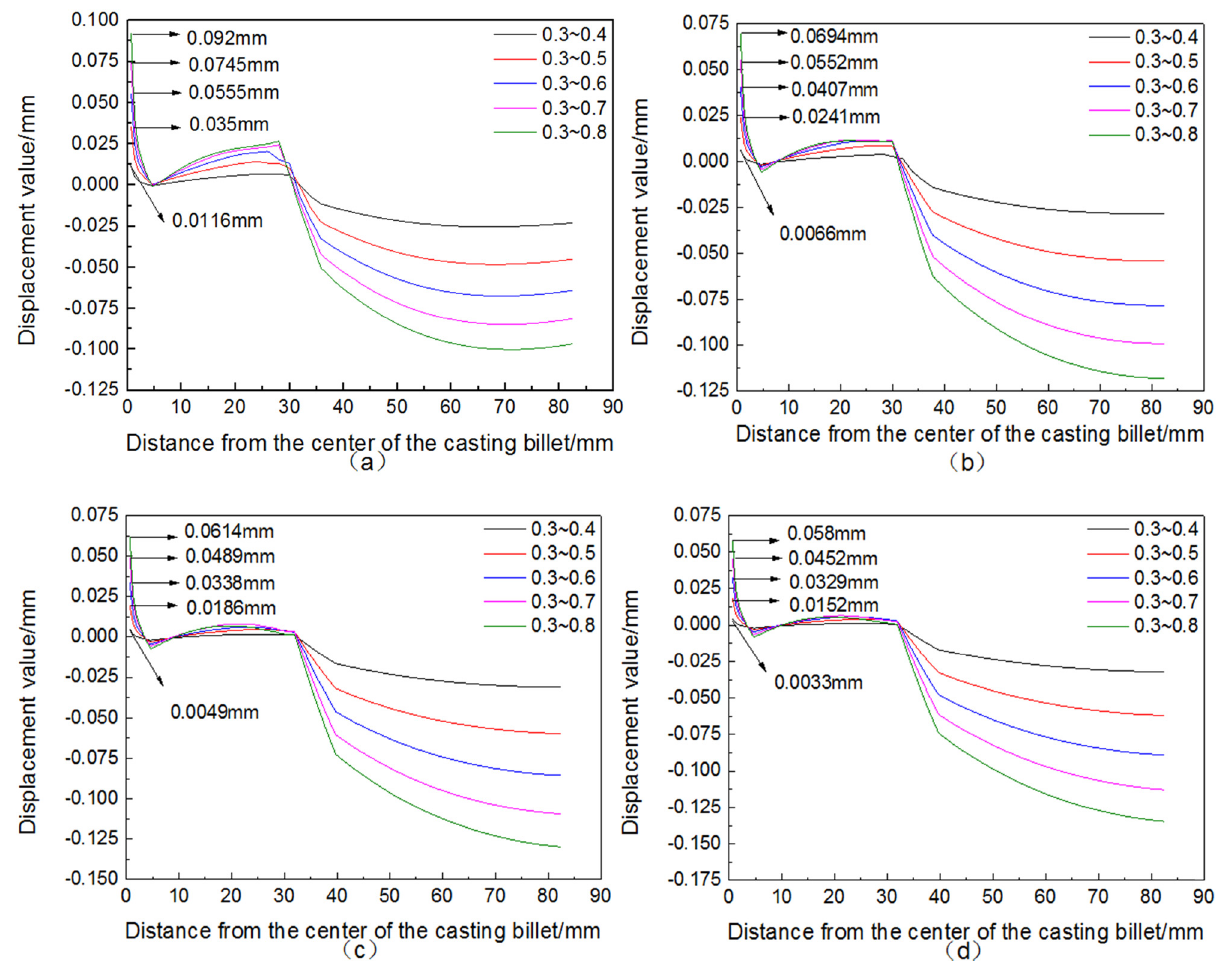
Figure 4: Displacement at di ff erent casting speeds: ( a ) 1.6 m · min − 1 , ( b ) 2.0 m · min − 1 , ( c ) 2.4 m · min − 1 , and ( d ) 2.8 m · min − 1